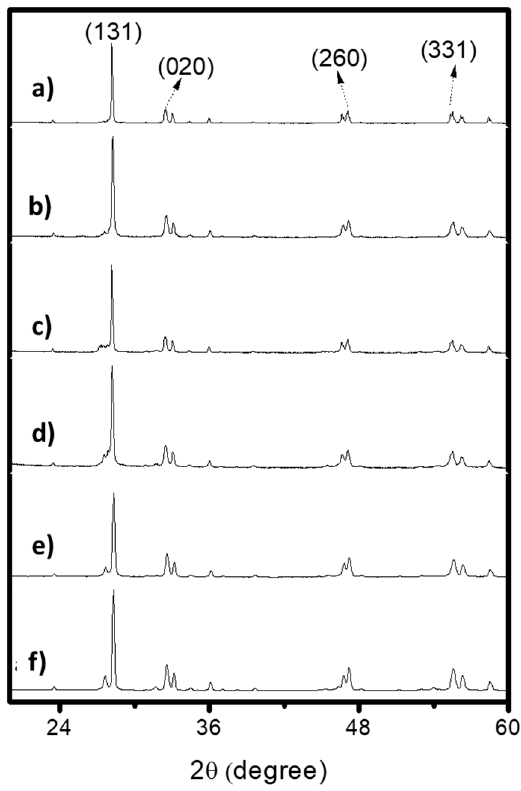
Figure 2. X-ray diffraction patterns of ( a ) AuMBR1, ( b ) AuMBR2, ( c ) OCMBR2, ( d ) OCMBR1, ( e ) MBR2, and ( f ) MBR1 synthesized catalysts. Cu K α radiation operating with a step size of 0.02°/min from 10° to 90°.